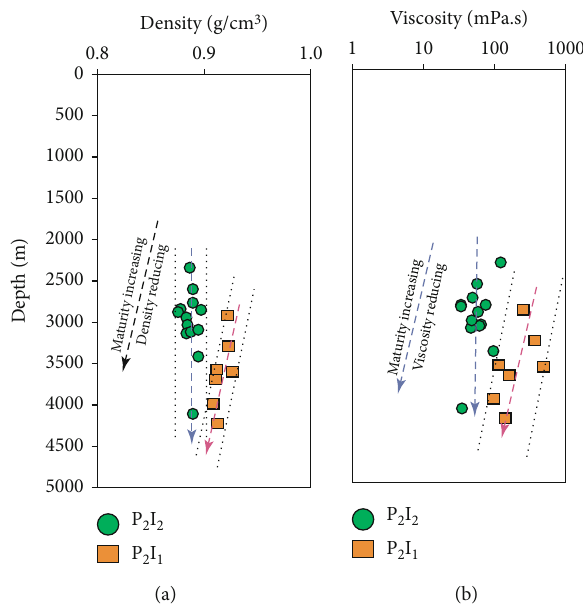
Figure 4: Cross-plots of (a) density versus depth and (b) viscosity versus